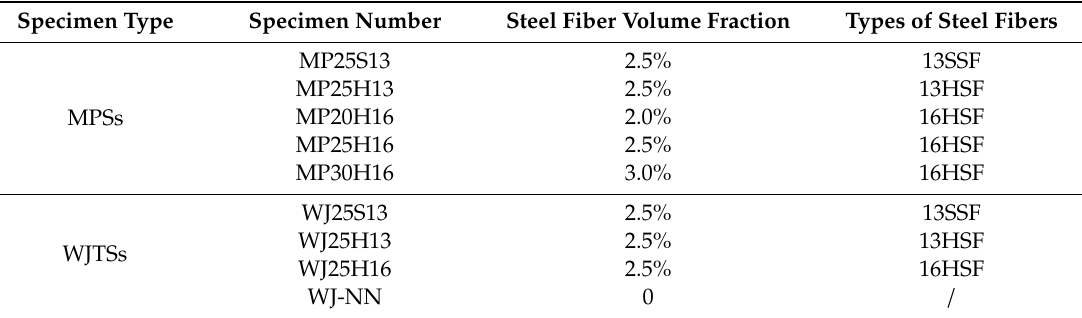
Table 3. Shear specimen parameters.